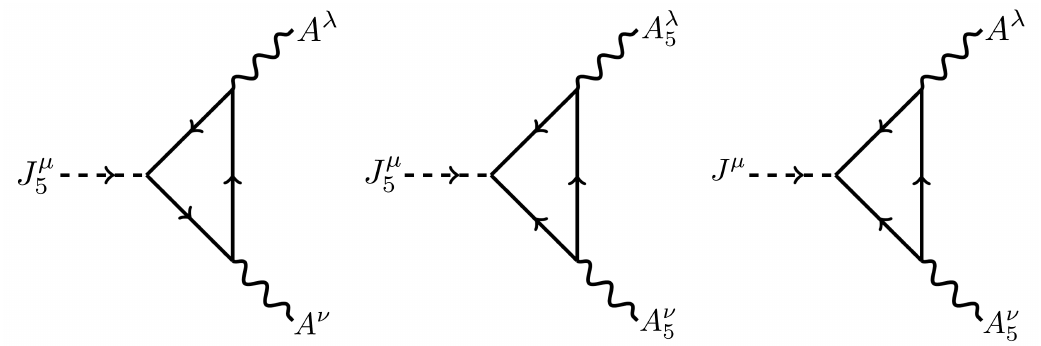
Figure 11: The two leftmost diagrams contribute to the axial current, while the third one is used to calculate the vector current. There are three more diagrams where the external A -lines are